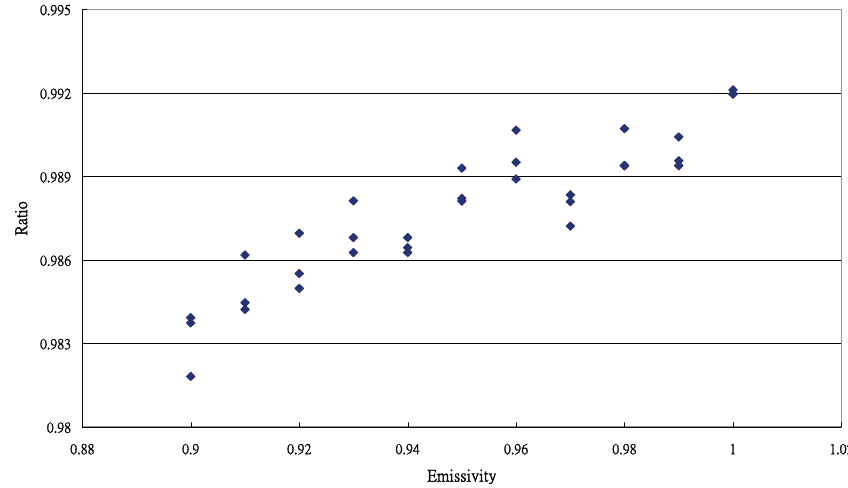
ε value for Phalaenopsis is